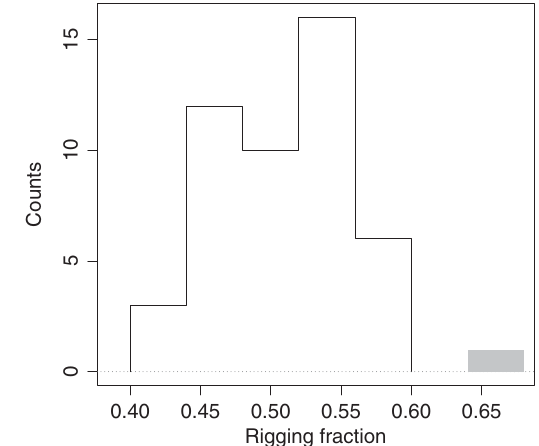
FIG. 2. Histogram of the rigging fraction for the subsets with a random starting point. The shaded gray box indicates the rigging fraction of the Singh subset. From this, we can see that the Singh subset has more problems in common with its nearest local optimum than do any of the random subsets